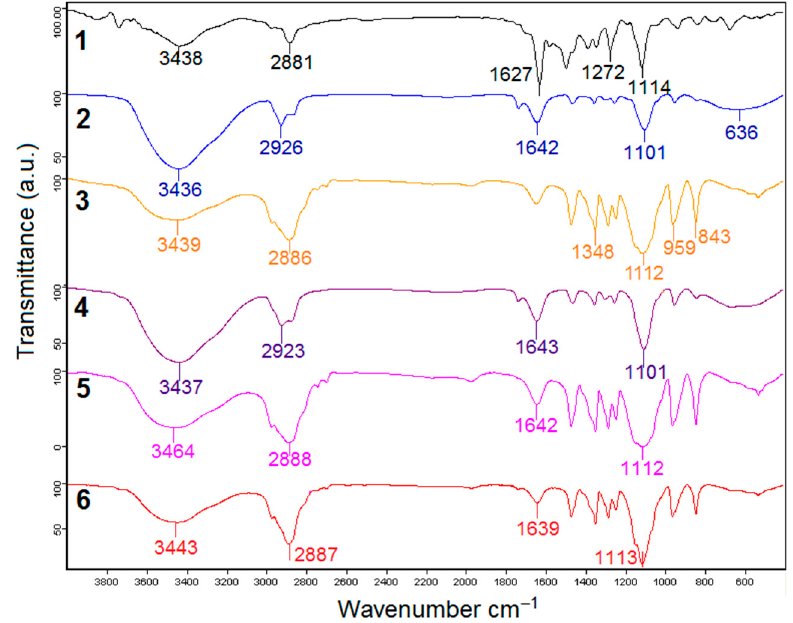
Figure 3. FTIR spectra of (1) Norfloxacin, (2) Cremophor EL, (3) Pluronic F127, (4) Norfloxacin in Cremophor EL micelles 100 µg/mL, (5) Norfloxacin in mixed micelles Cremophor EL-Pluronic F127 and (6) Norfloxacin in Pluronic F127 micelles 100 µg/mL.